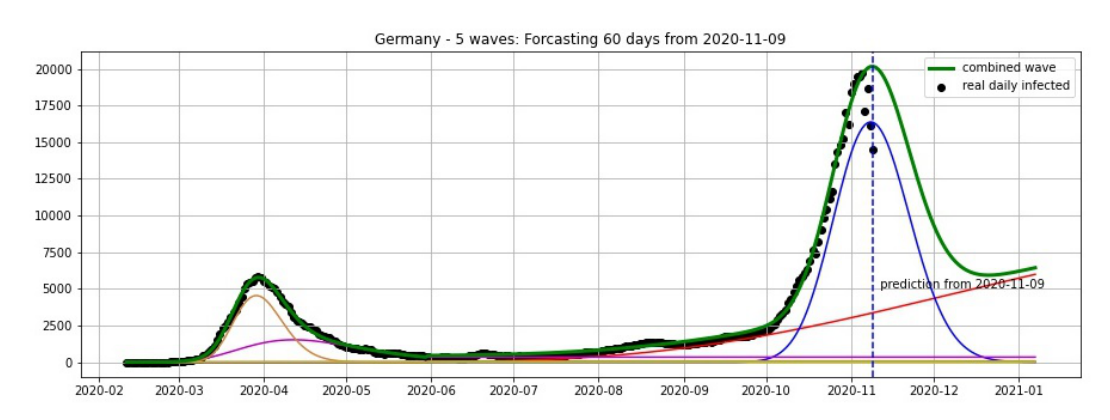
Figure 13. France: fitting and forecasting from 9 November with 5 wavelets. The green curve is the combination of other curves which are EF wavelets.